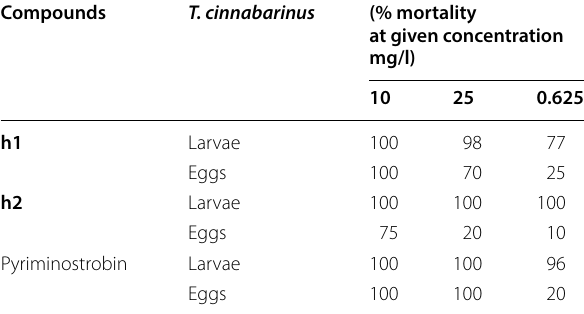
Table 50 Acaricidal activity of h1 and h2 against